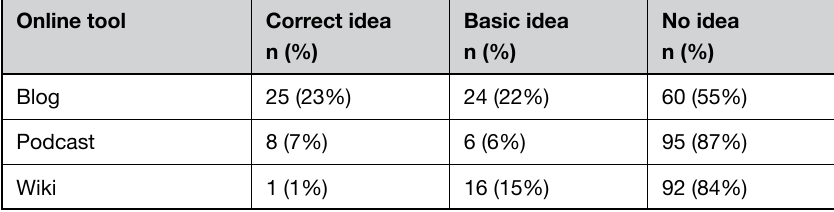
Table 3: Participants’ understanding of common online tools (N=109) Online tool